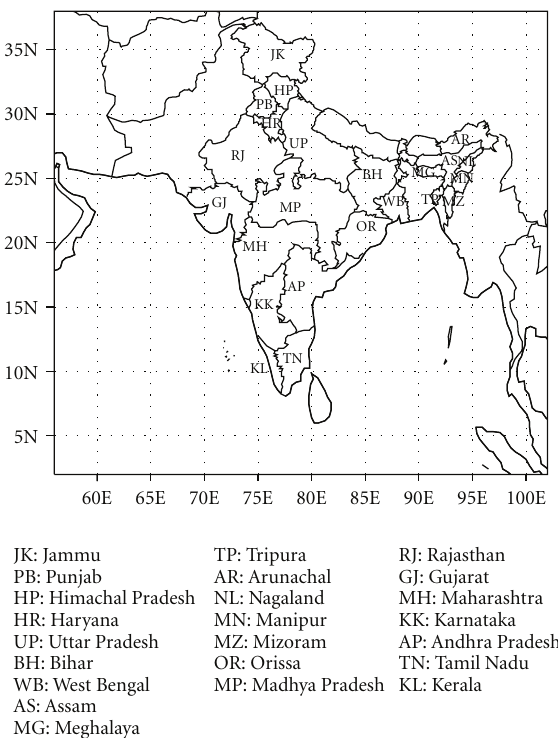
Figure 6: Geographical location of states of India.